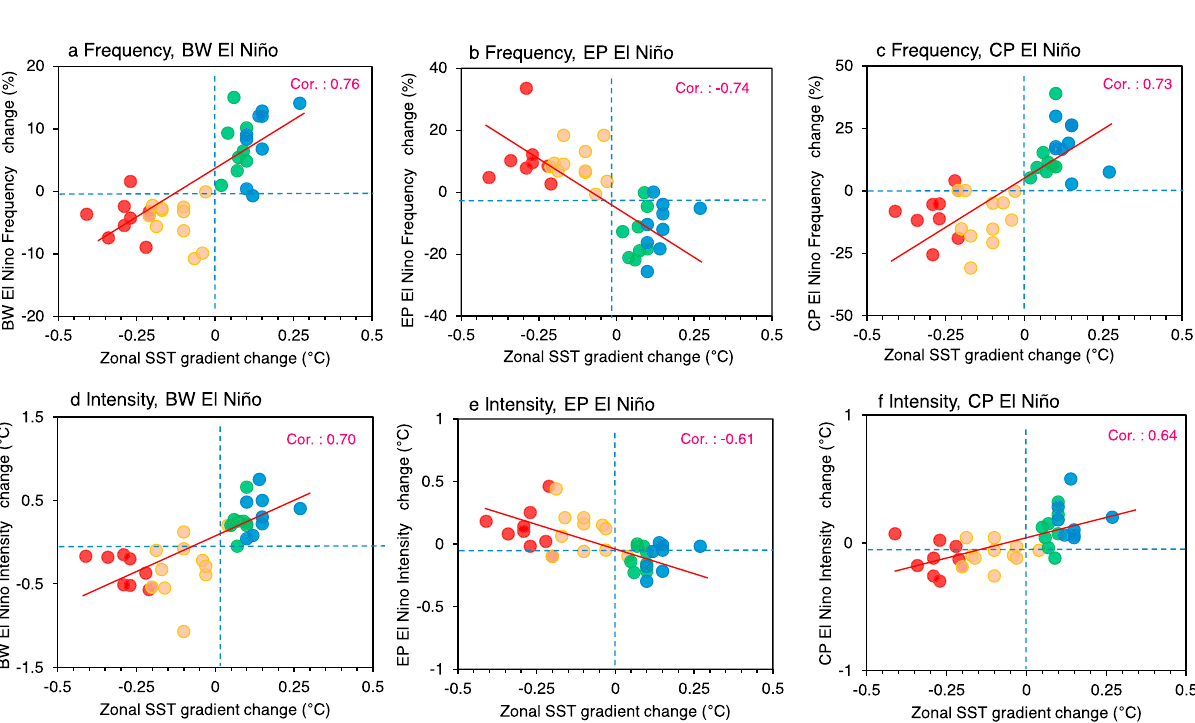
Fig. 3 Relationship between zonal SST gradient and frequency/intensity change according to El Niño type. a – c Relationship between zonal sea surface temperature (SST) gradient changes over equatorial Paci fi c ( x -axis, units: °C) and frequency change of the Basin-wide (BW), Eastern Paci fi c (EP), and Central Paci fi c (CP) types of El Niño, respectively ( y -axis, units: %). The zonal SST gradient is de fi ned as the SST difference between the western Paci fi c (5°S – 5°N, 155°E – 175°W) and the eastern Paci fi c SST (5°S – 5°N, 115°W – 145°W). d – f Same as a – c but for the intensity change of the three El Niño types ( y -axis, units: °C). The intensity is measured by boreal winter (October to February) SST anomalies averaged over 5°S – 5°N and 80°W – 180°W. The frequency (or intensity) changes are differences between historical (1943 – 1992) and Representative Concentration Pathway (RCP) 4.5/8.5 (2038 – 2087) scenarios. Red (blue) dots represent the models with El Niño-like (La Niña-like) mean SST change. Eighteen climate models were used. The linear regression line is shown as the solid red line in each panel, with correlation coef fi cient. Red (orange) dots represent the models experiencing strong (weak) El Niño-like mean SST changes, while blue (green) dots indicate strong (weak) La Niña-like mean SST changes in the